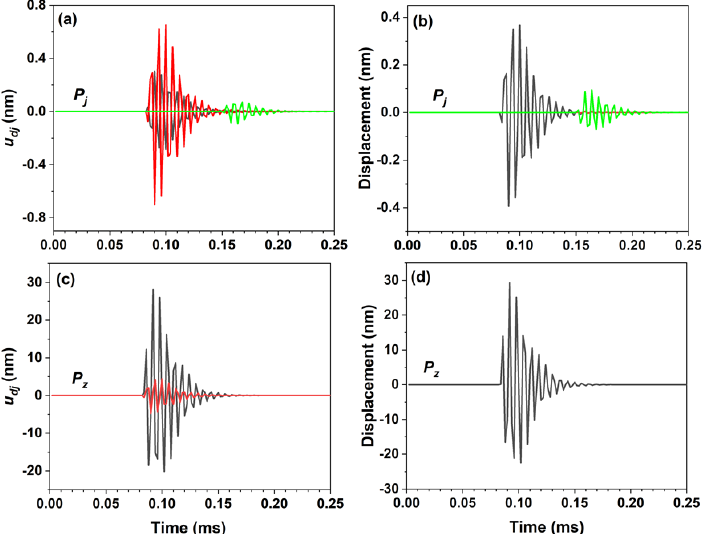
Figure 3. Effect of the b parameter of the point source on the envelopes of the simulated 𝑢 𝑟𝑗 wave- forms: (1) 6 × 10 4 , (2) 8 × 10 4 , (3) 1 × 10 5 , (4) 2 × 10 5 , and (5) 4 × 10 5 . (1) 6 × 10 4 , (2) 8 × 10 4 , (3) 1 × 10 5 , (4) 2 × 10 5 , and (5) 4 × 10 5 .